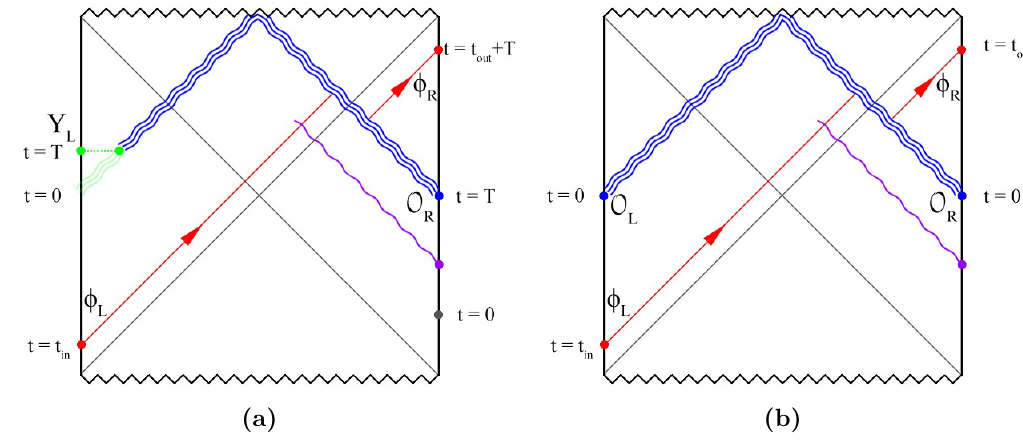
Figure 3 . a) The memory of the probe can be modi(cid:12)ed by sending an early perturbation from the right. b) The same setup for the thermo(cid:12)eld